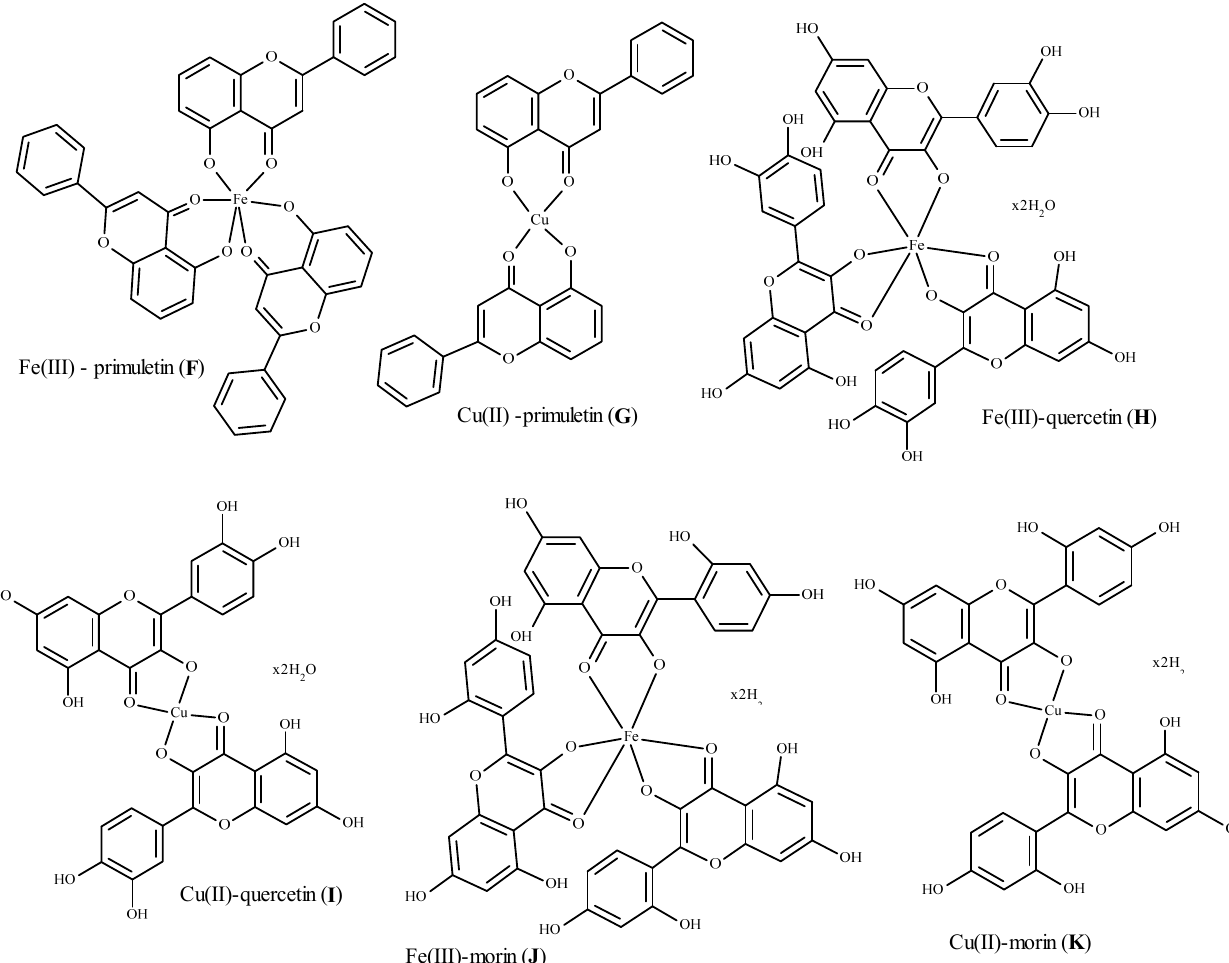
Figure 6. Structures of Fe(III) and Cu(II) complexes ( F–K) with primuletin ( 29 ), quercetin ( 3 ) and morin ( 28 ).